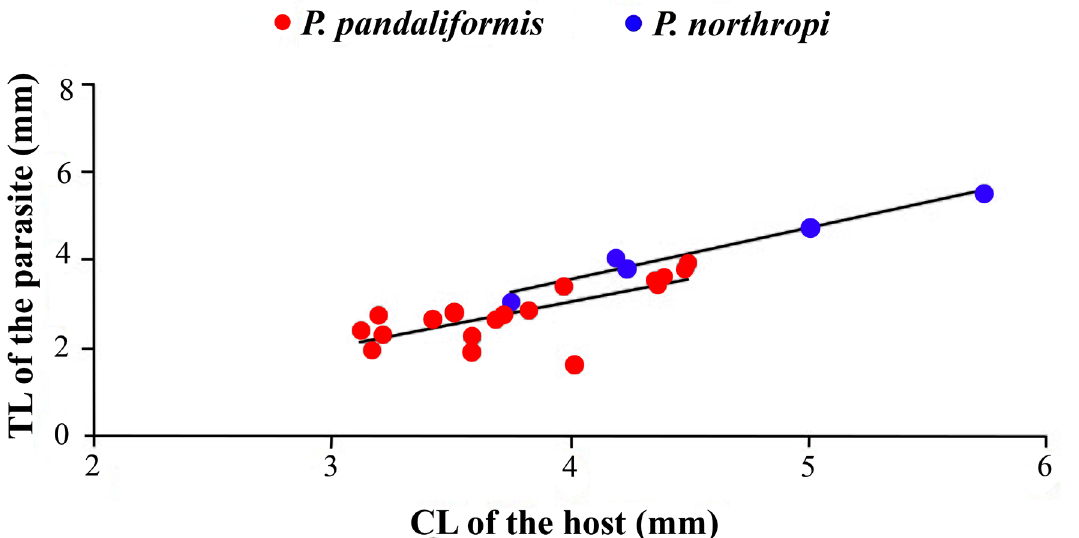
Figure 2. Relationship between carapace length (CL, mm) of the hosts Palaemon northropi and P. pandaliformis and total length (TL, mm) of their parasite, Probopyrus sp. Linear regression equation for P. pandaliformis size and probability value: TL = 1.051 CL – 1.1306 (p = 0.0003; r 2 = 0.54). Linear regression equation for P. northropi size and probability value: TL = 1.172 CL – 1.116 (p = 0.002; r 2 =